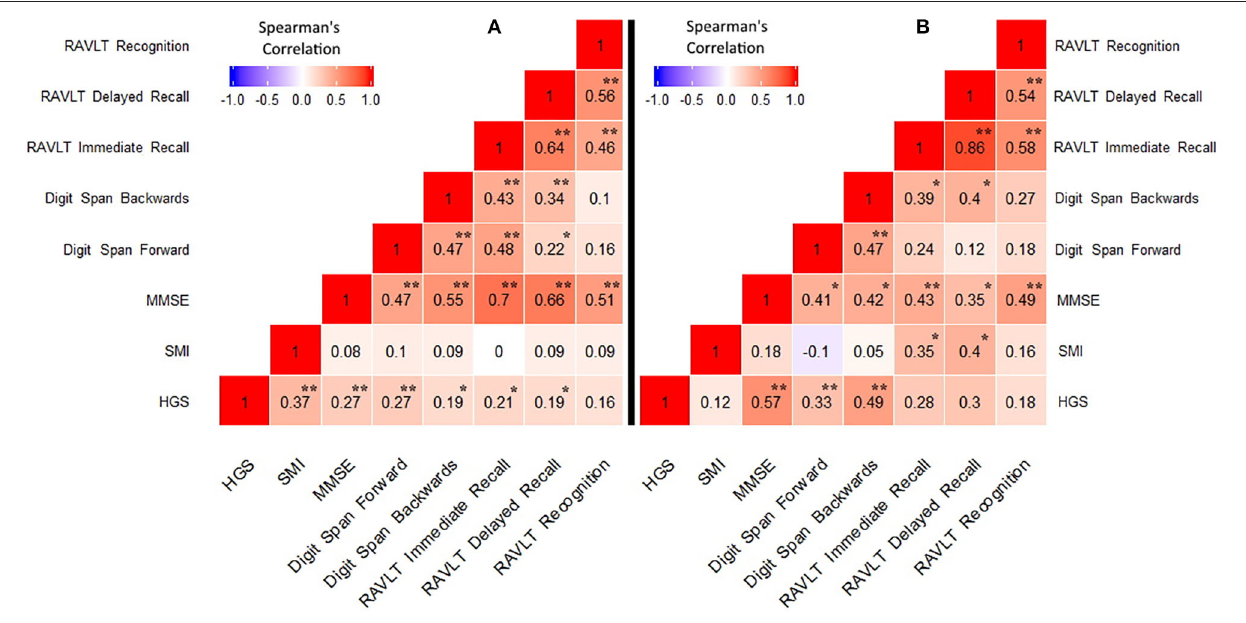
reduction of handgrip strength in patients with moderate- stage AD compared to controls and patients with early- stage AD, and in patients with mild and early-stage